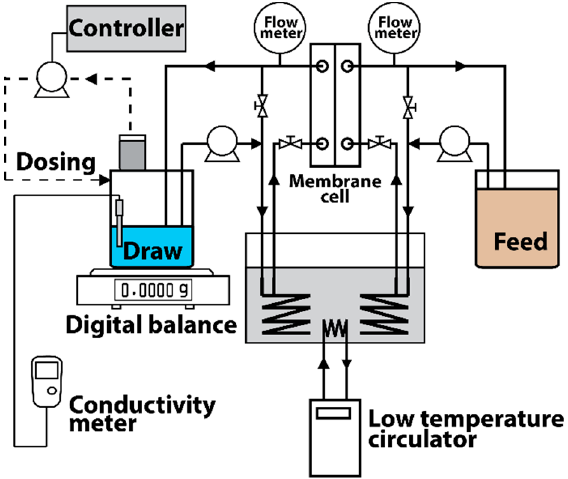
Figure 1. Schematic diagram of the forward osmosis (FO) system.